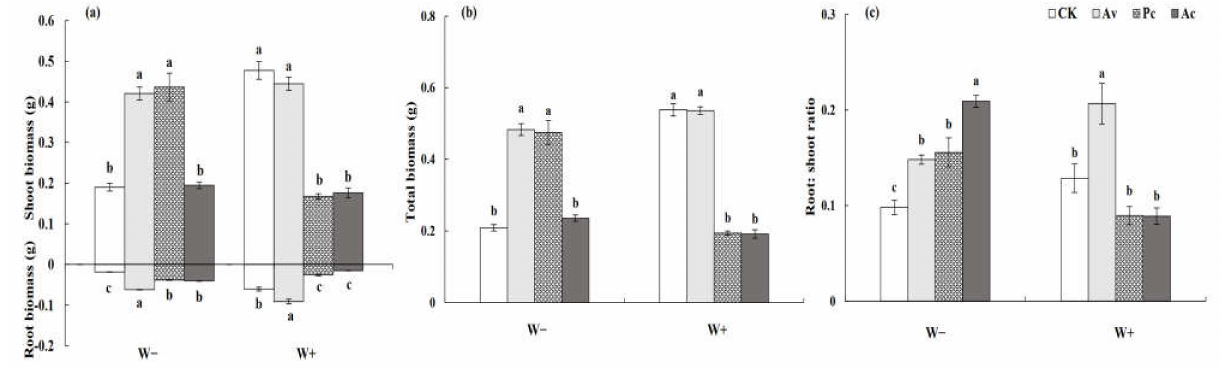
Figure 11. Effects of dark septate endophyte (DSE) on the biomass production and root–shoot ratio of Artemisia ordosica seedlings under drought stress. Different letters above the error bars indicate a significant difference at p < 0.05. Note: ( a ), shoot and root biomass, ( b ), total biomass, ( c ), root:shoot ratio. W − , drought treatment. W+, well-watered treatment. CK, non-DSE inoculated control. Ac, Pc, and Av, plants inoculated with Alternaria chartarum , Paraphoma chrysanthemicola , and Acrocalymma vagum .